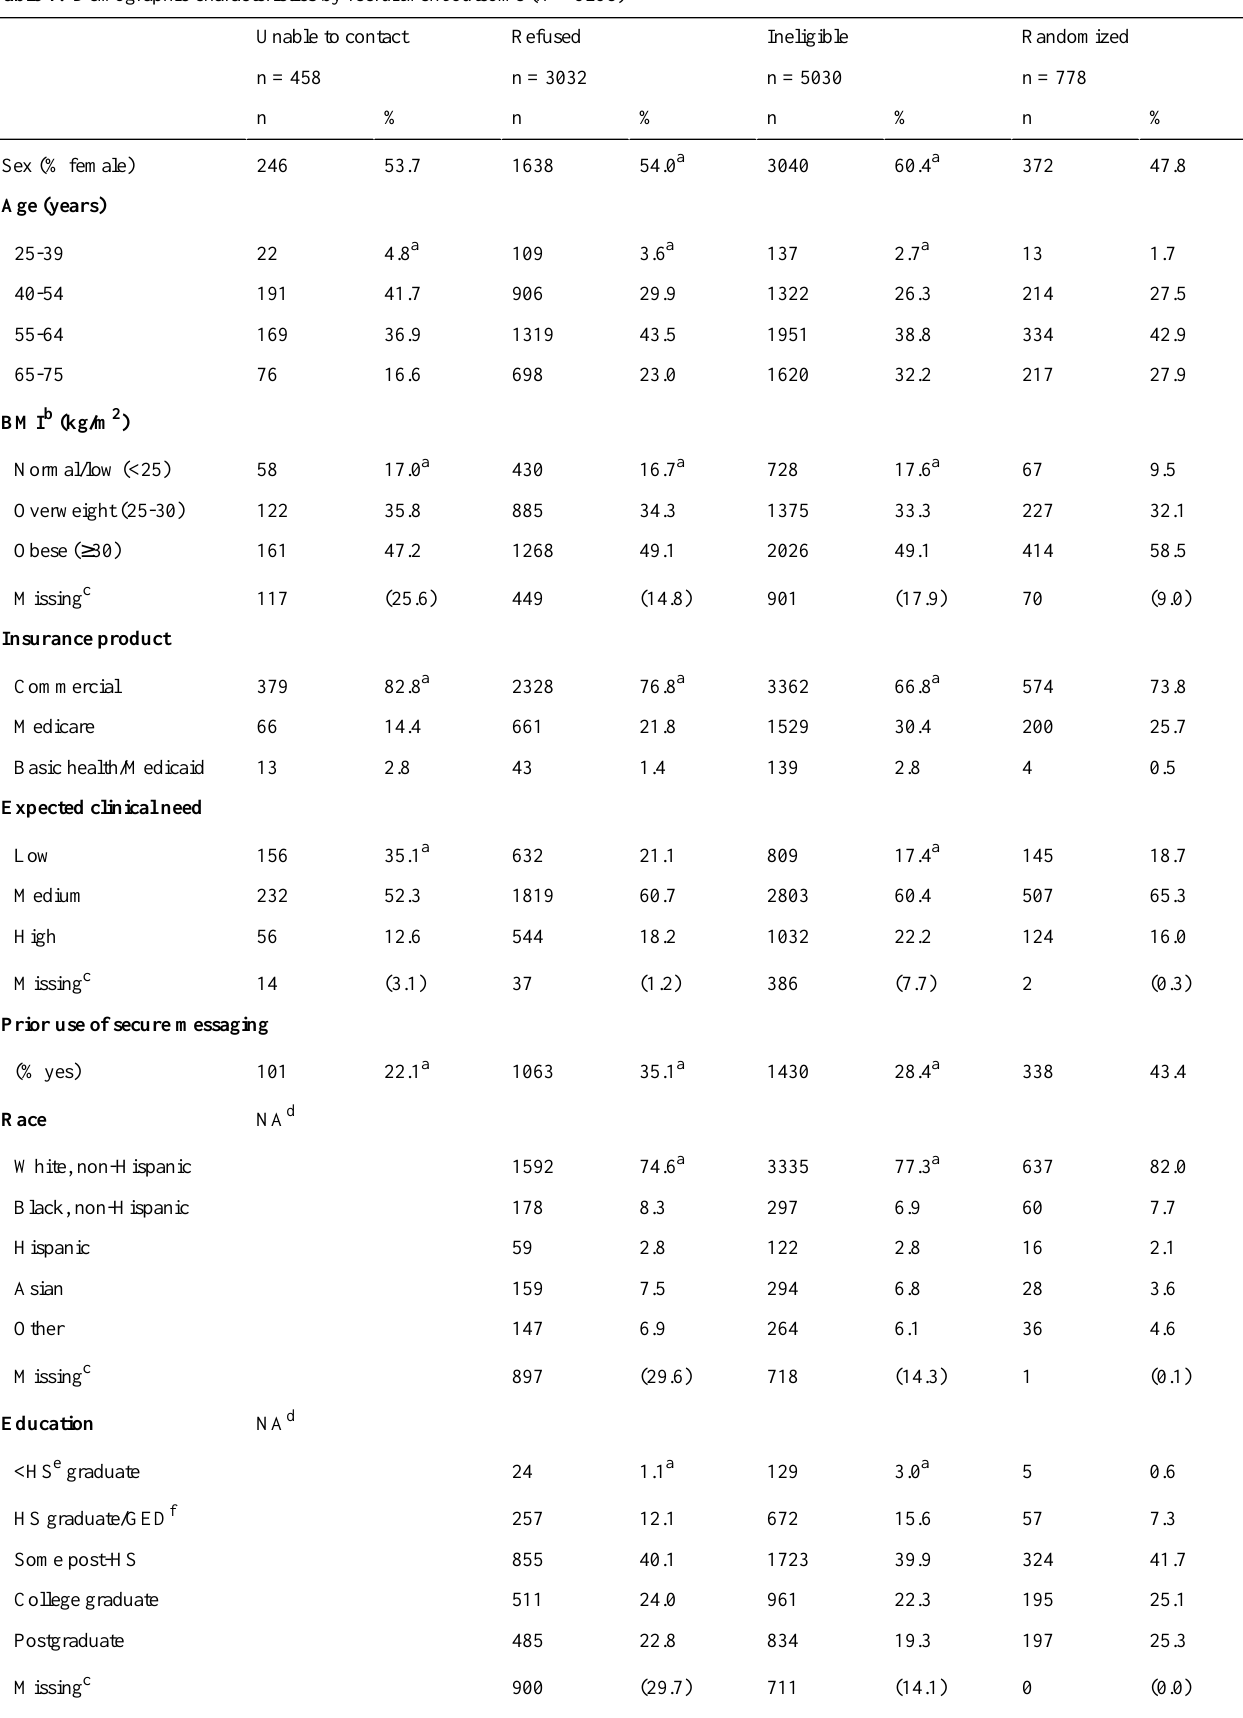
Table 1. Demographic characteristics by recruitment outcome (N = 9298) RandomizedIneligibleRefusedUnable to